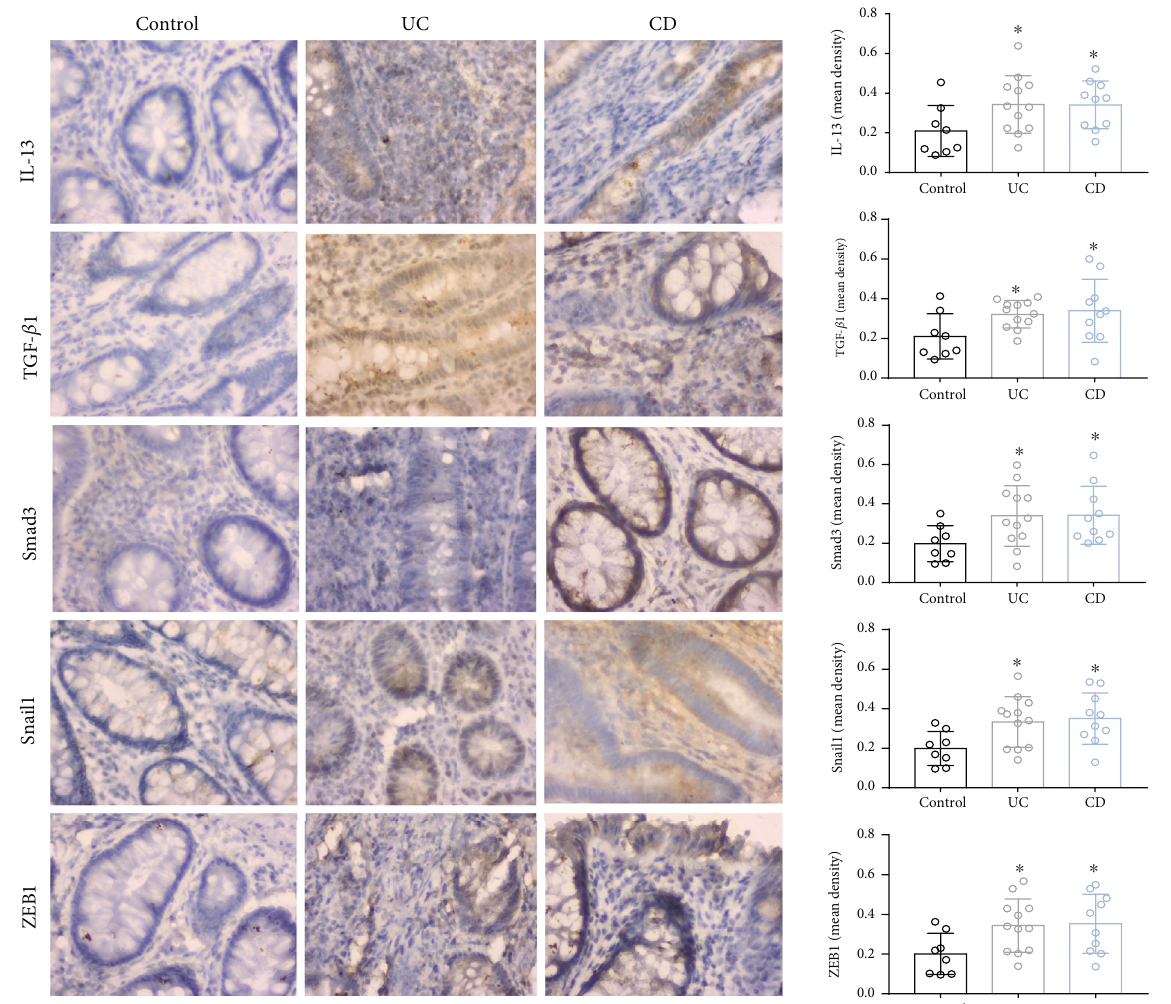
Figure 5: IL-13, TGF- β 1, Smad3, and EMT-related transcriptional factor expression in IBD colon tissues. Immunohistochemical staining of IL-13, TGF- β 1, Smad3, ZEB1, and Snail1 in intestinal tissues of controls, ulcerative colitis (UC), and Crohn ’ s disease (CD) patients (400x). Data were given as mean ± SD . As compared to the control group: ∗ P < 0 : 05 , ∗∗ P ≤ 0 : 01 , and ∗∗∗ P ≤ 0 : 001